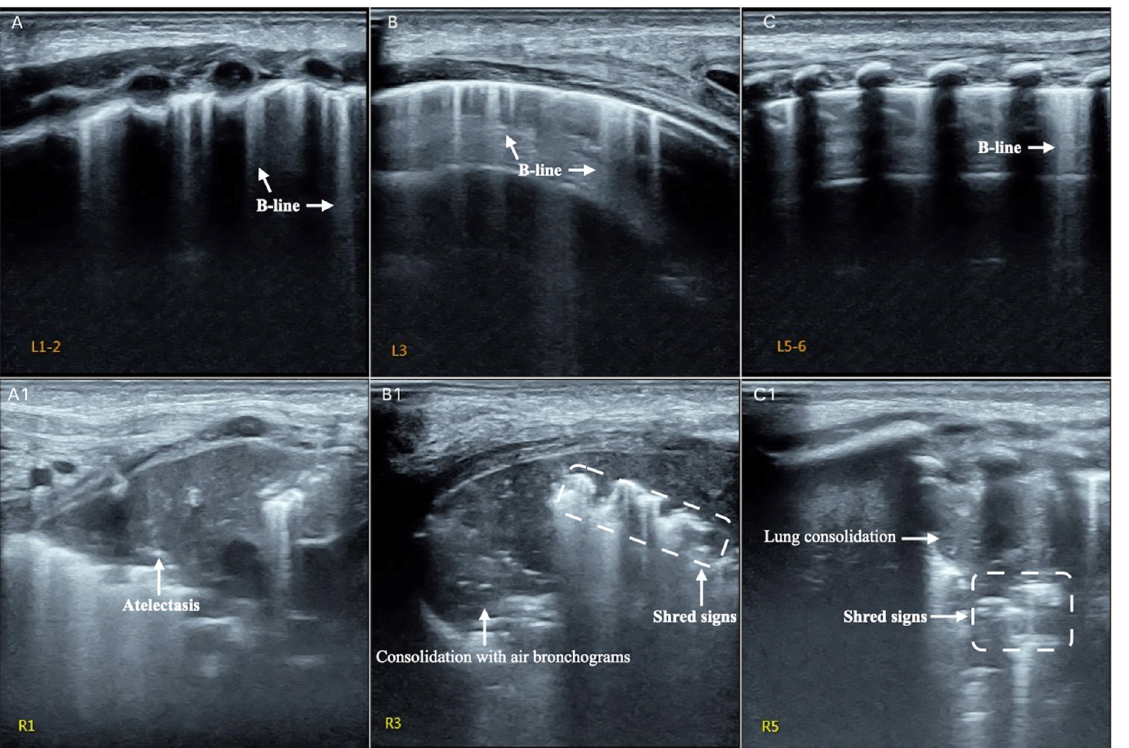
Figure 3. LUS manifestations of neonatal fungal pneumonia. It can be seen from the picture that the left lung mainly shows a few B-lines, suggesting the presence of mild lung edema. In the right lung, there was obvious consolidation with air bronchograms and shred signs in the subaxillary and posterior areas. Atelectasis was seen in the upper lung field of the right anterior chest. ( A ): the left anterior lung field, ( B ): the left subaxillary lung field and ( C ): the left posterior upper lung field. ( A1 ): the right anterior upper field, ( B1 ): right subaxillary upper lung field and ( C1 ): right posterior upper lung field.